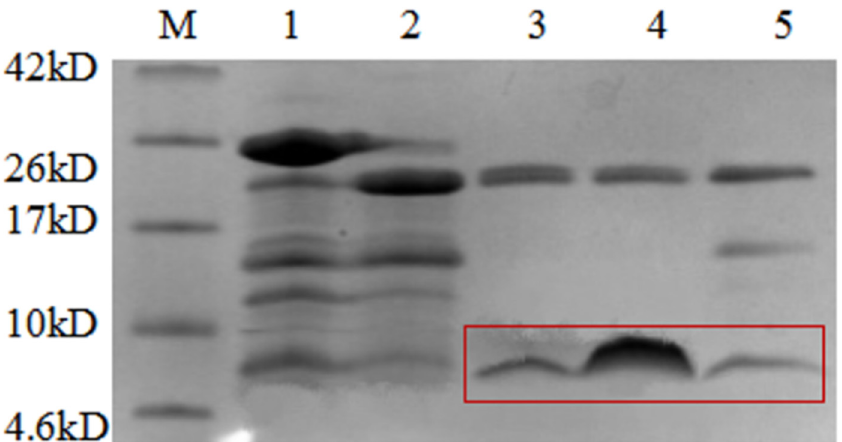
Figure 5. Tricine SDS-PAGE analysis of AMPs cleaved by HRV 3C. M, protein molecular weight marker. Lane 1, the nickel column before digestion; lane 2, the nickel column after digestion and elution; lane 3, the digestion supernatant; lane 4, HRV 3C Cleavage buffer; lane 5, 1M NaCl.